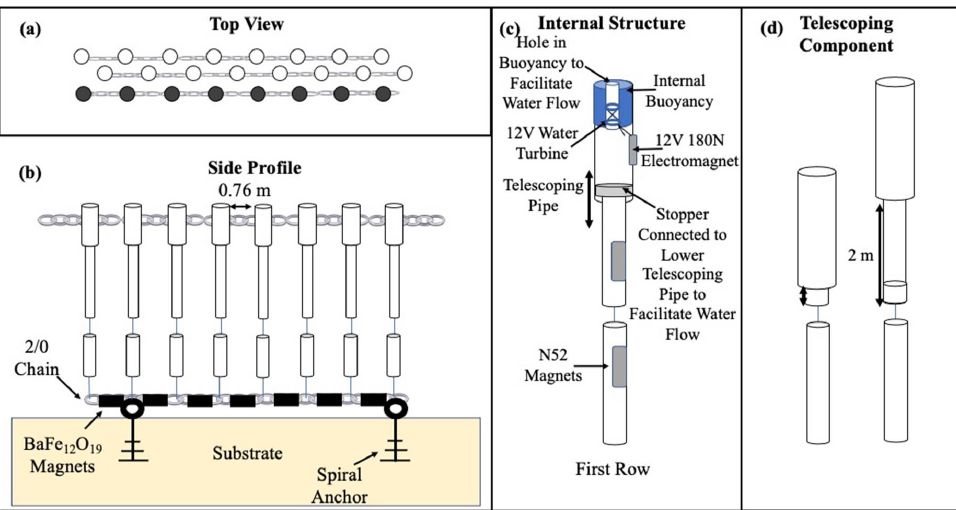
Figure 4. Exclusion barrier experimental setup. ( a ) Top view. The barrier was composed of three, 25 m long alternating rows of barrier piping. The outer row consisted of piping equipped with equally spaced 3.2 cm × 2.54 cm N52 Neodymium (Nd 2 Fe 14 B) disc magnets (i.e., black circles), whereas the two inner rows of piping contained unmanipulated piping (i.e., white circles). ( b ) Side profile of the outer row of piping. Pipes were 2 m long when contracted and an inner telescoping unit allowed for the pipes to be a maximum of 3 m long. Pipes were separated by 0.76 m and were connected to the seafloor using a flexible heavy duty 2/0 chain. To facilitate the technology’s semi-net-like appearance, flexible heavy duty 1/0 chain was attached to the apex of each barrier unit. Located between adjacent pipes and along the chain was a 15.2 cm × 10.2 cm × 5.1 cm grade C8 BaFe 12 O 19 permanent magnet. The chain was secured to the seafloor by Sealux stainless steel spiral anchors. ( c ) Internal structure of the first (outer) row and remaining rows of the barrier structure. Inside the polyvinyl chloride (PVC) piping of the outer row was one DC 12V 180N electromagnet that was directly connected to one 12V hydroelectric power generator. A stopper was attached to the apex of the lower unit of the telescoping pipe to force water flow through the top of the barrier unit. With the hydroelectric power generator positioned within the high-density buoyancy foam at the top of the barrier element, this maximized water flow through the device and maximized the voltage produced during heavy sea conditions (e.g., waves that exceed 0.25 m). The second and third rows of PVC piping were unmanipulated and only contained the high-density foam to maximize pipe buoyancy. ( d ) View of the telescoping component associated with each barrier unit. This component of the barrier allowed for an additional 2 m extension of each barrier unit to aid with tidal